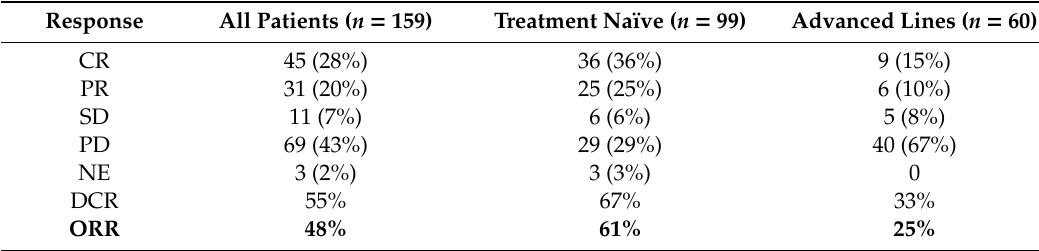
Table 2. Response rates to combined ipilimumab and nivolumab